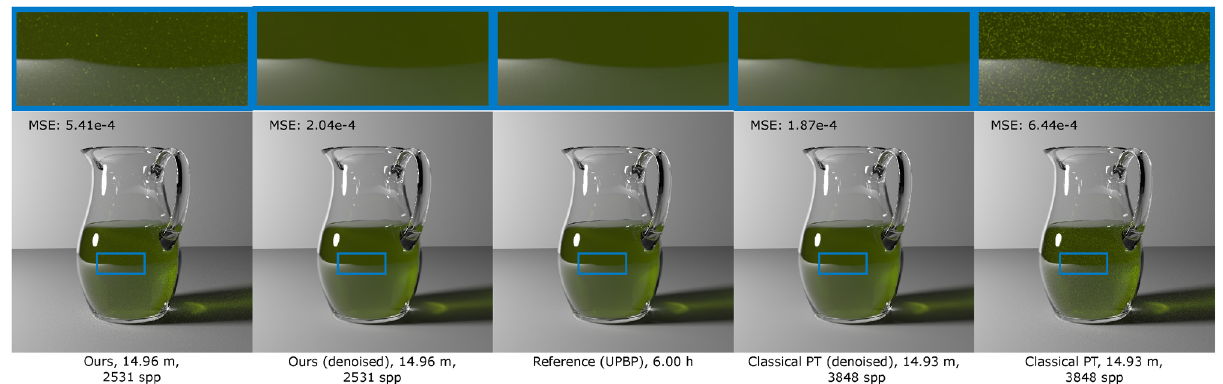
Fig. 8 Comparison of our method and path tracing with equal time for the Oil scene.